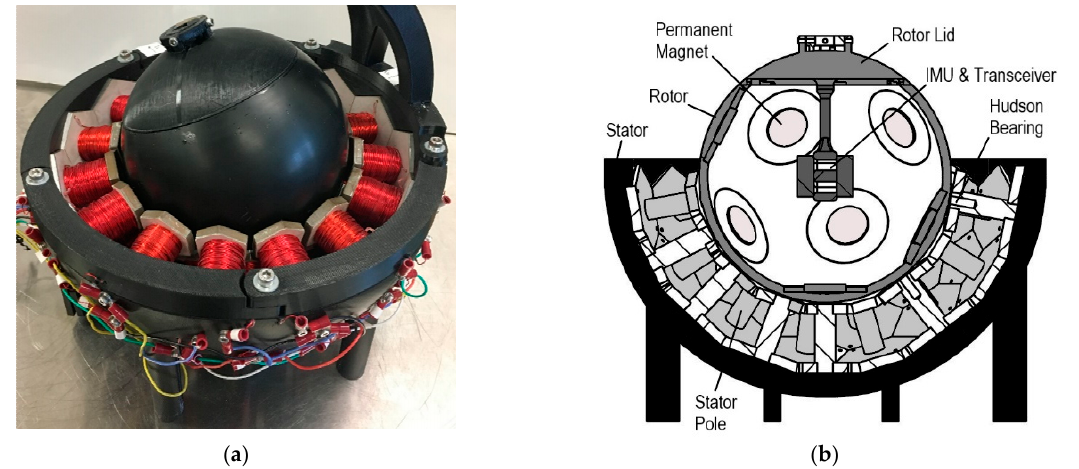
The final PMSSM prototype, detailing the fully assembled rotor and stator sub-assemblies,